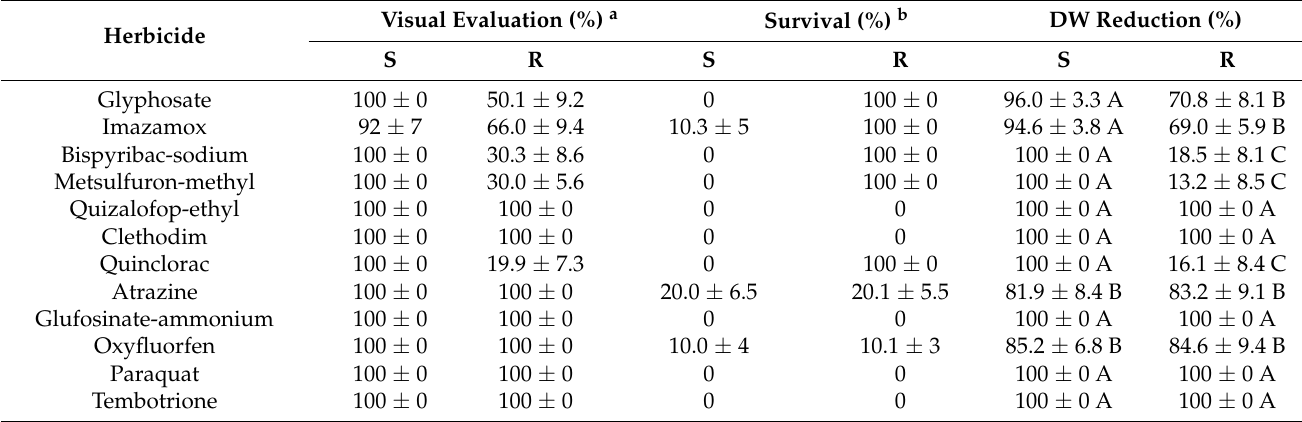
Table 2. Effect of glyphosate and imazamox, and the alternatives herbicides used in “ Integrated chemical management assay ” in Chloris radiata . Percentage of visual evaluation, survival and dry weight (DW) reduction compared to the untreated controls in the resistant (R) and susceptible (S)